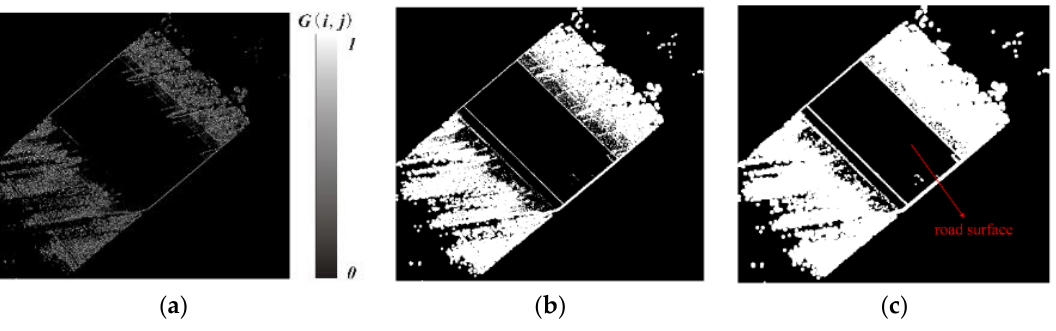
Figure 6. ( a ) Elevation-gradient image; ( b ) image after binarization; and ( c ) image after dilation.